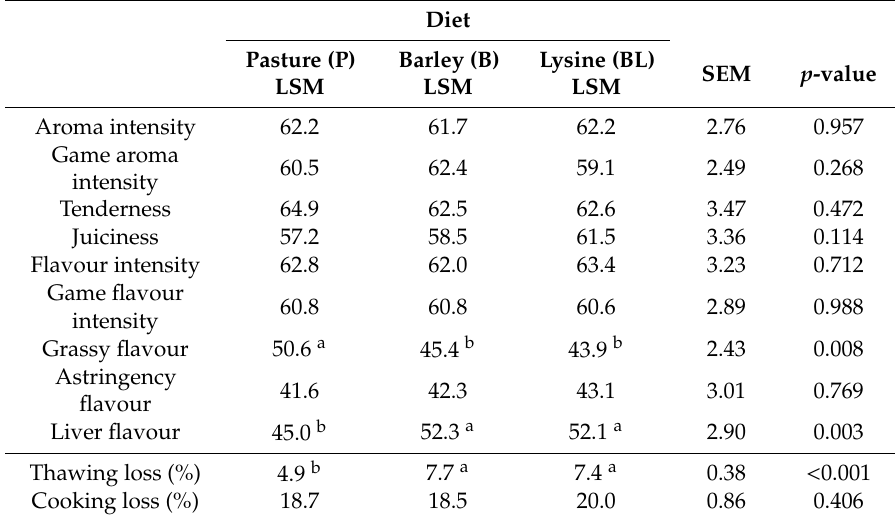
Table 6. Sensory characteristics (scores from 0 to 100) and technological properties of fallow deer longissimus lumborum muscle, after the deer were fed di ff erent diets. Diet Pasture (P) Barley (B) Lysine (BL) SEM p -value LSM LSM LSM Aroma intensity 62.2 61.7 62.2 2.76 0.957 60.5 62.4 59.1 0.268 intensity